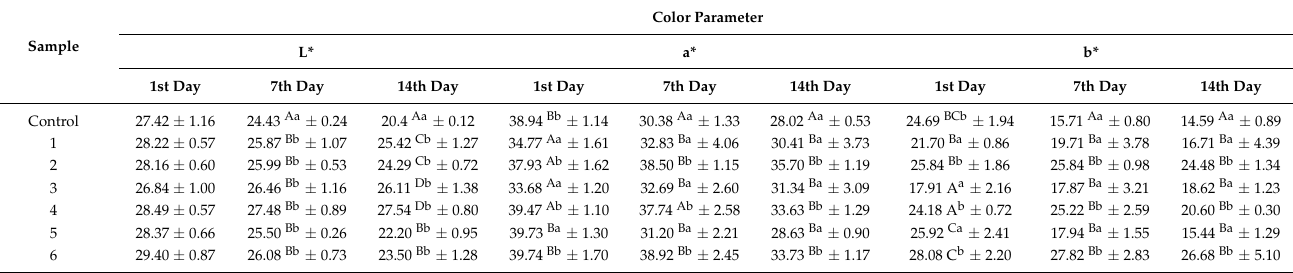
Table 1. Color Parameter during